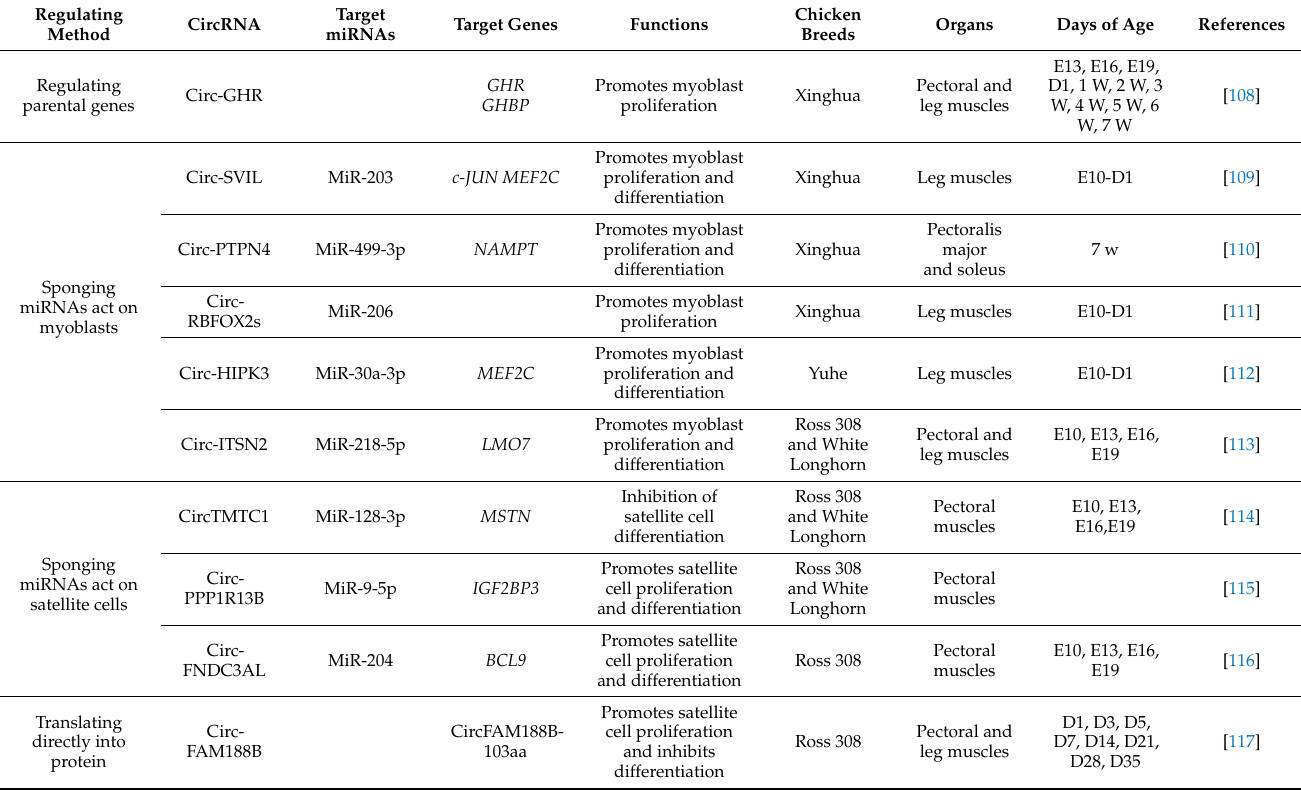
Table 4. Species and functions of circRNAs involved in skeletal muscle of domestic